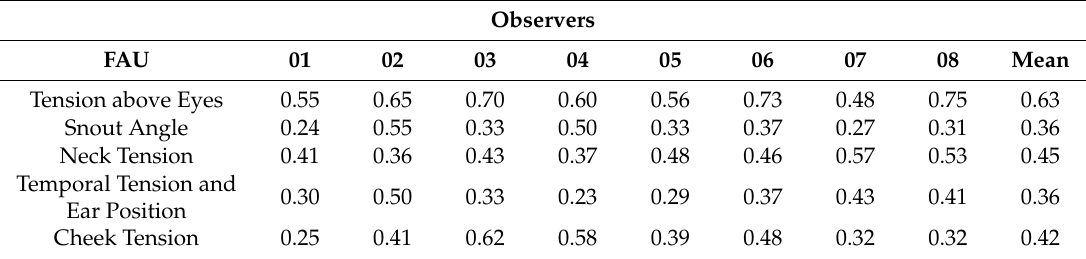
Table 2. Inter-observer reliability (Kappa Coe ffi cient) between the individual and mean evaluation of eight observers (from 01 to 08) and the Silver Standard of the five facial action units (FAUs) of 60 sow face images.